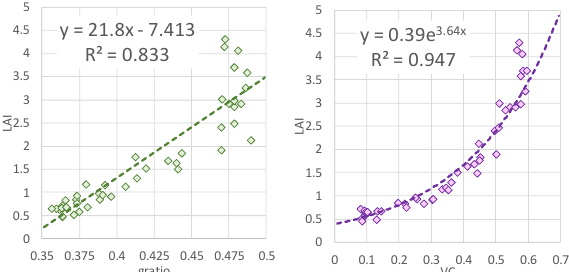
Figure 8. Relations of LAI with gratio and VC